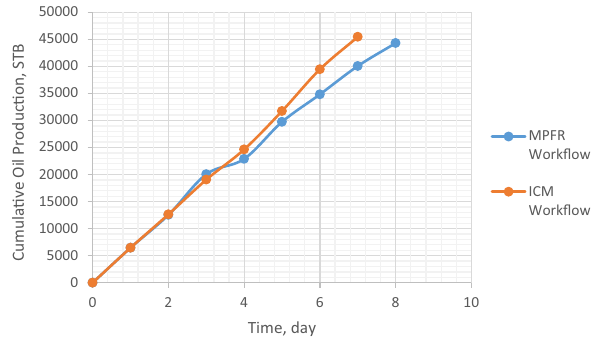
Fig. 12 Cumulative oil production at the end of ICM and MPFR